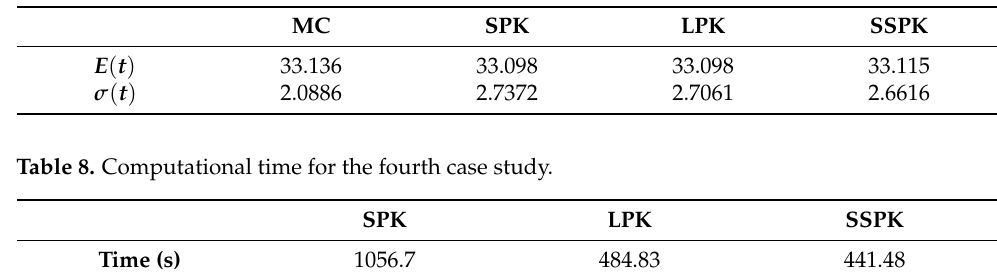
Figure 3. Histogram of times for the fourth case study. Table 7. Mean and variance of times for the fourth case study.